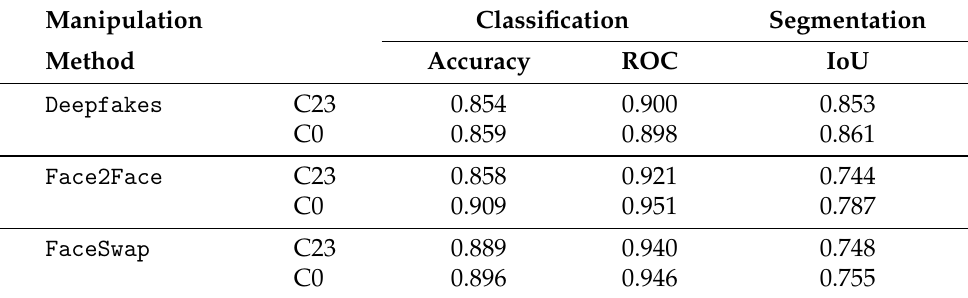
Table 2. Results for detecting fullsize images altered by three manipulation